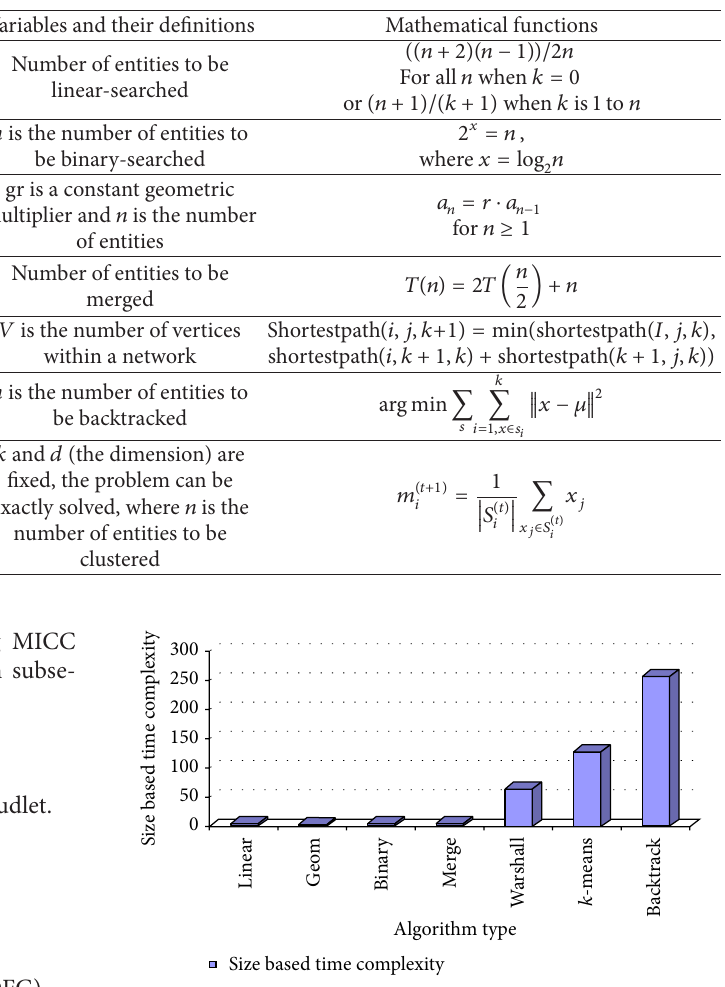
Table 2: Algorithm and time complexity.